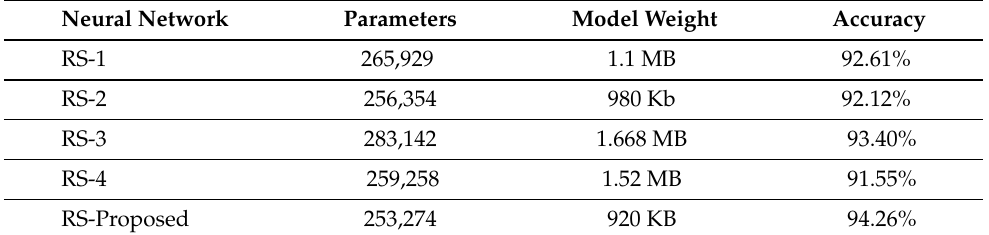
Table 4. Parameters, model weight, and accuracy of several models in ablation